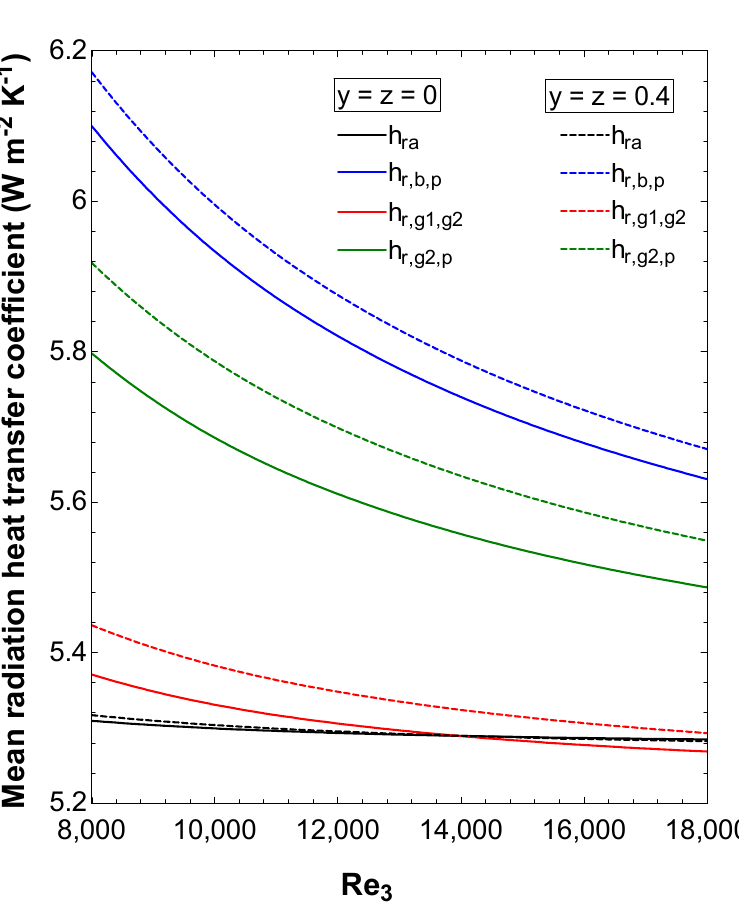
Figure 4. Comparison of the mean radiation heat transfer coefficient for the base case and the case with y = z = 0.4.